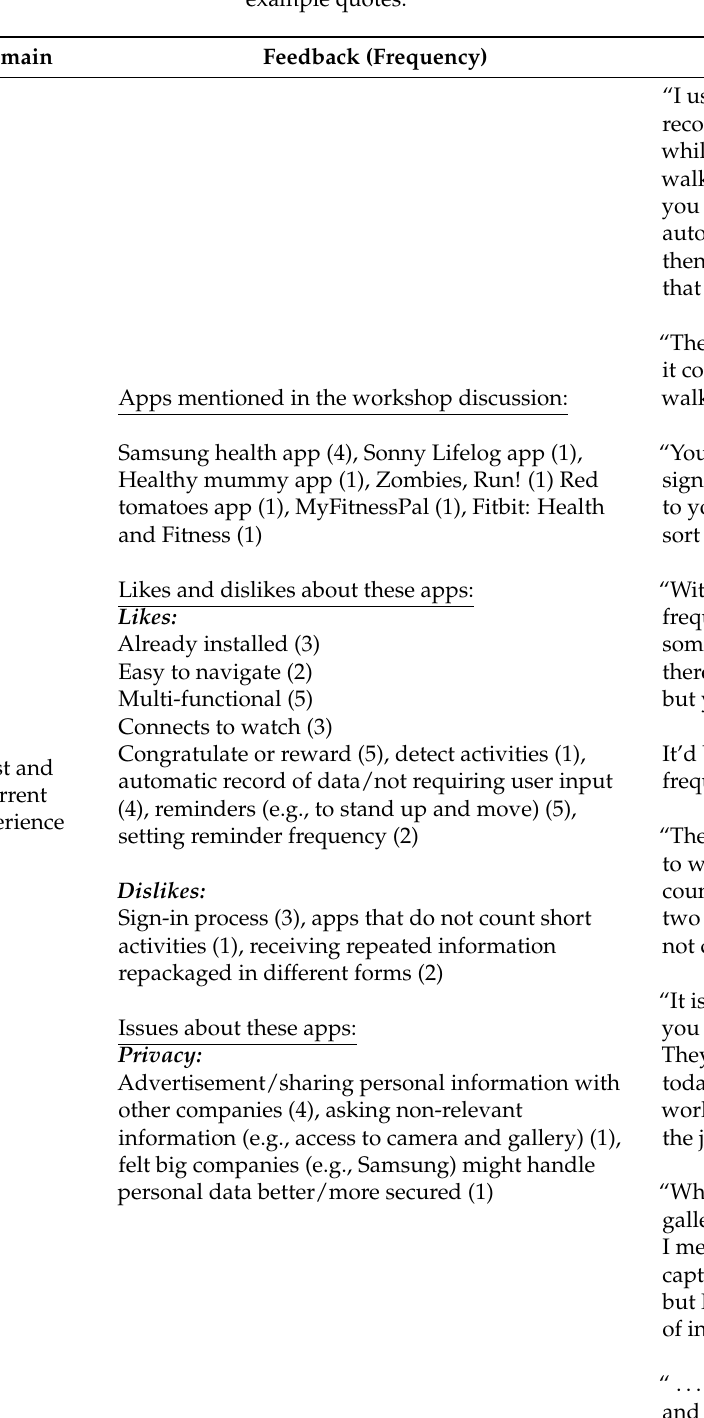
Table 3. Results of the iMOVE app focus group including domains, feedback (frequencies), and example